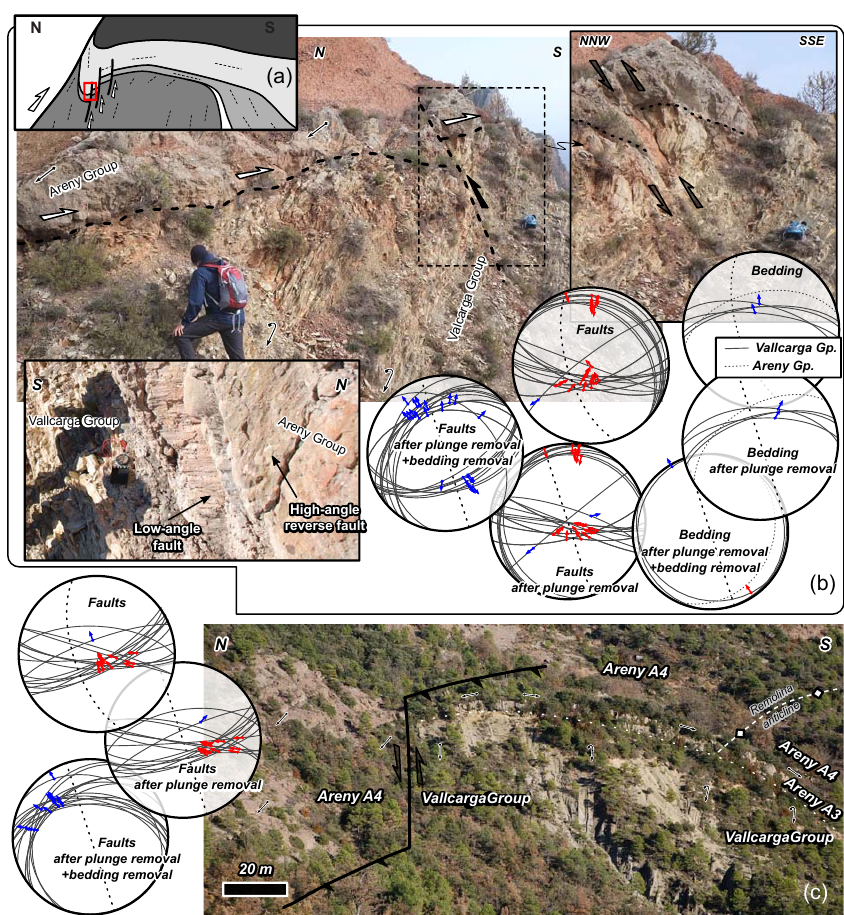
Figure 3. Transitional area between the San Maximí syncline and the Remolina anticline. (a) Cross-sectional location of the site. (b) Shallow- dipping unconformity between the Areny and the Vallcarga groups reactivated as a low-angle fault and displaced by a high-angle fault. Details of the low- and high-dipping faults are shown, together with stereoplots of faults and bedding surfaces of the Vallcarga Group. (c) Panoramic view and stereoplot of a near-vertical fault system uplifting the Remolina anticline, which has folded strata of the Areny Group unconformably on top of near-vertical strata of the Vallcarga